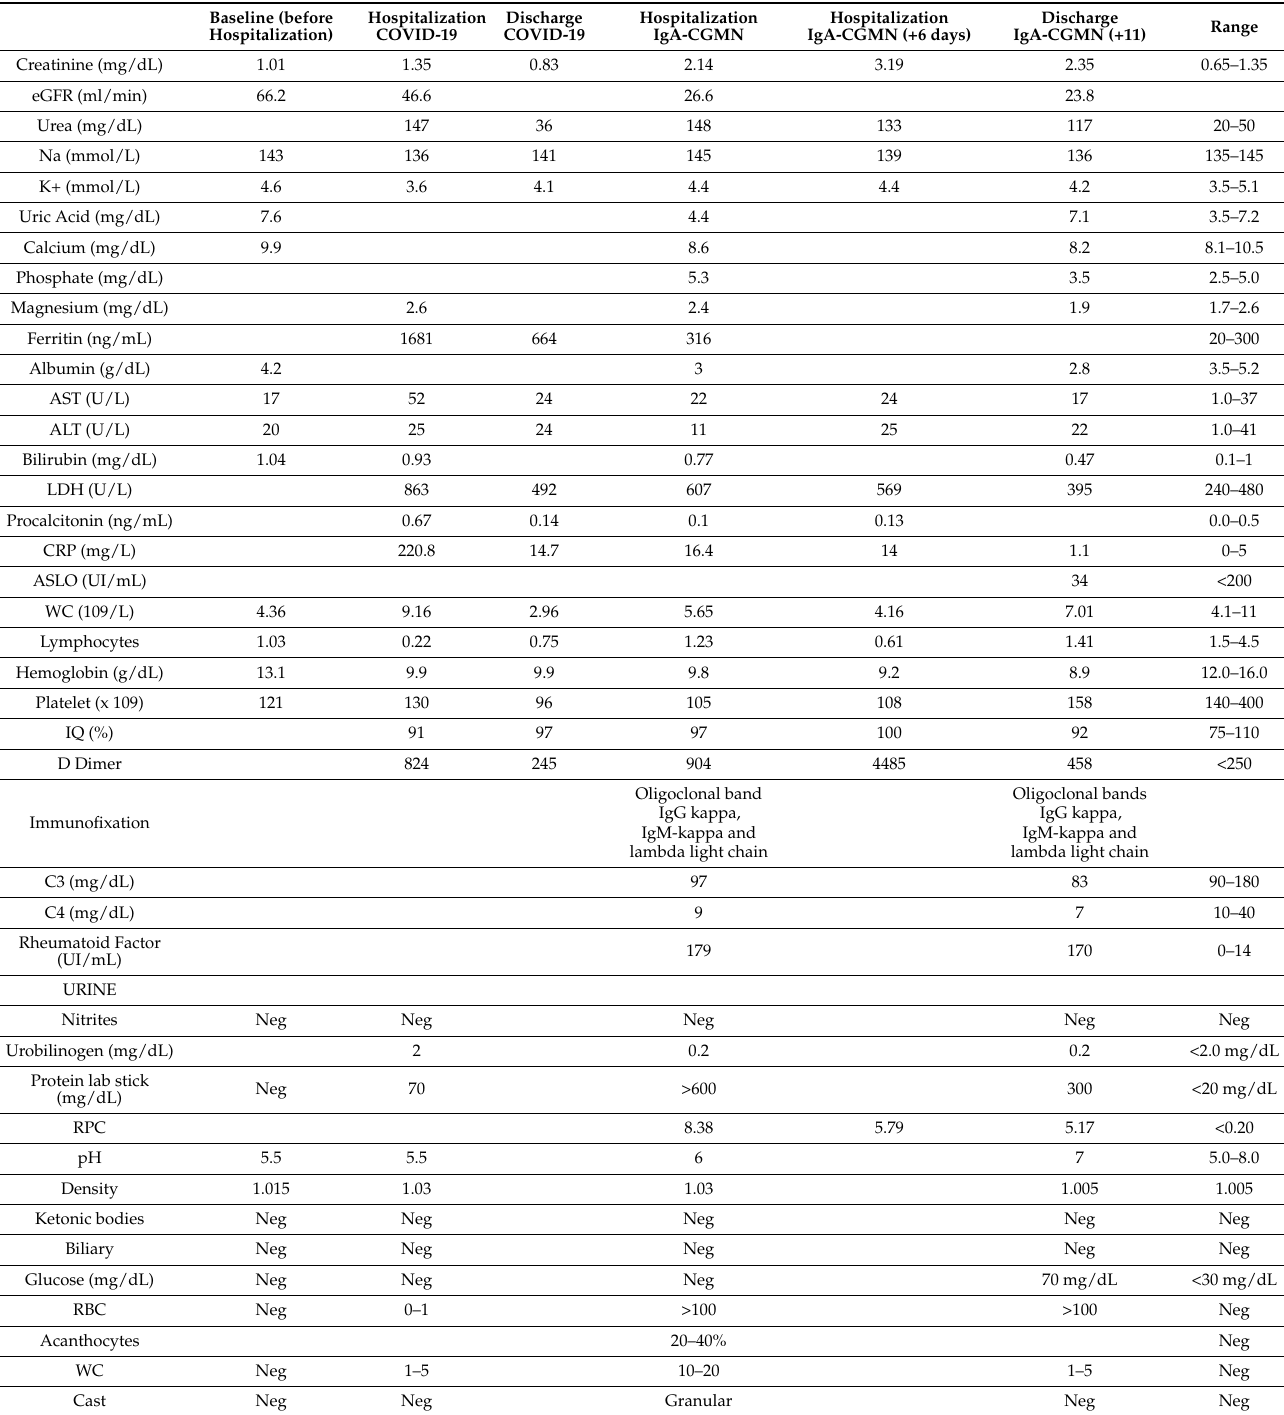
Table 1. Patient clinical